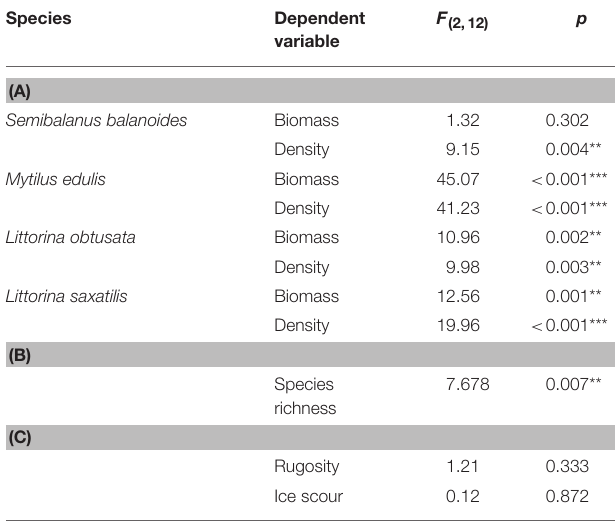
TABLE 4 | Summary statistics of one-way ANOVAs (A) assessing the effect of treatment [“Full canopy,” “Reduced canopy” and “Bare (start)”] on biomass and density of dominating intertidal faunal species in Kobbefjord August